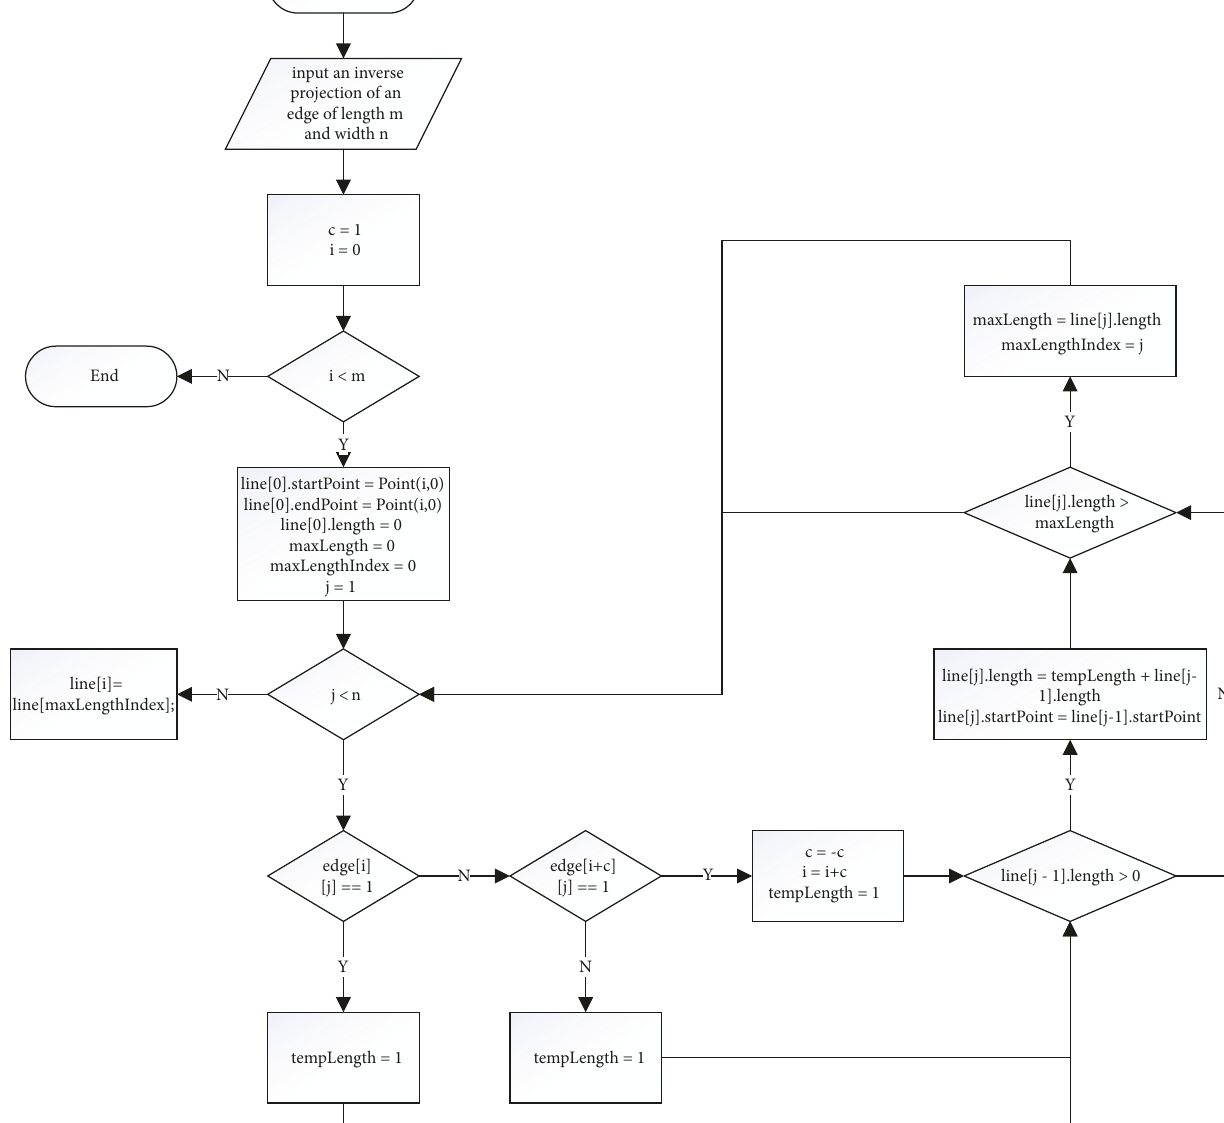
Figure 49: Algorithm for detecting straight lines based on the inverse